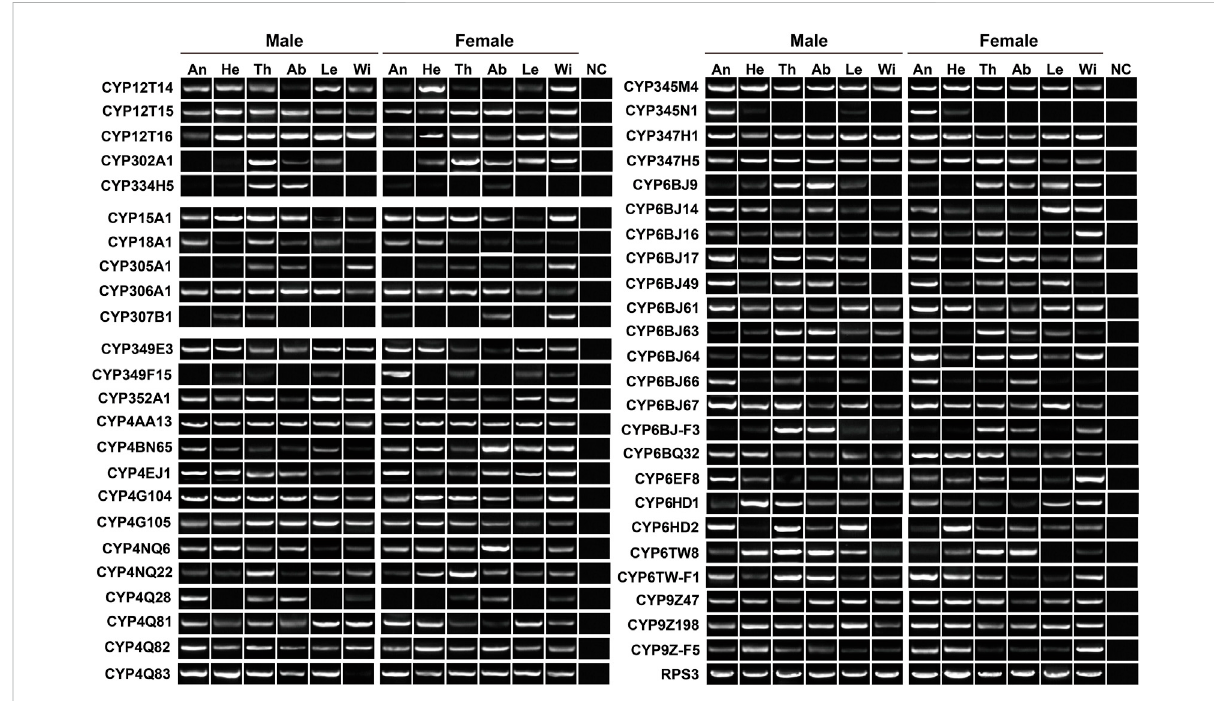
FIGURE 4 Expression pattern of 48 P450 genes in various tissues of P. antennata . The abbreviation of tissues is seen in Table 1. NC, negative control using sterile water as the